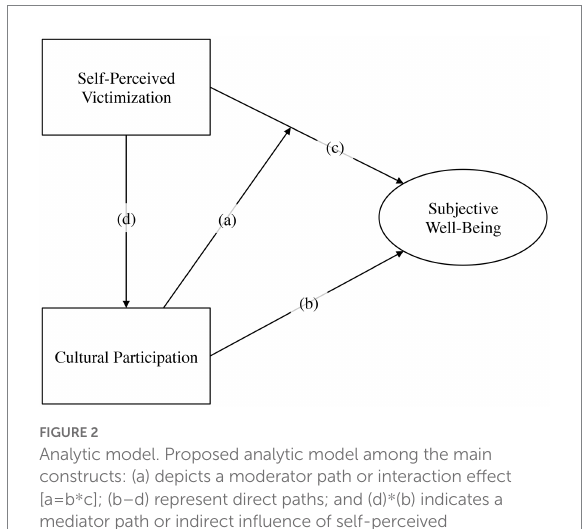
FIGURE 2 Analytic model. Proposed analytic model among the main constructs: (a) depicts a moderator path or interaction effect [a = b * c]; (b–d) represent direct paths; and (d) * (b) indicates a mediator path or indirect influence of self-perceived victimization on subjective